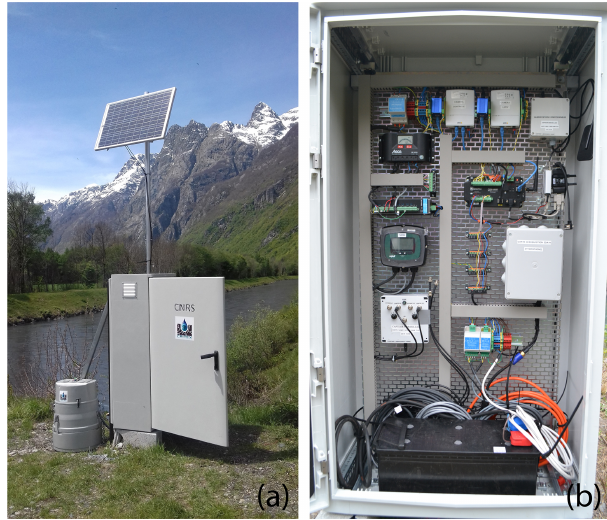
Figure 3. Photos of the box that houses all the electronics of the platform and the battery: (a) outside view where we also see the solar panel and the ISCO automatic river water sampler and (b) inside